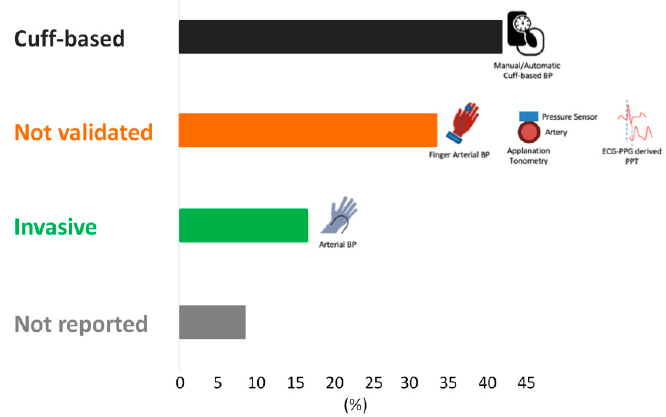
Figure 5. A representation of the gold standards used by each study to obtain the reference blood pressure. BP cuff—sphygmomanometer, either manual or automatic; not validated—Volume-clamp method, applanation tonometry (use of pressure sensors on the artery to detect systolic BP), or another PPG technology that has not been fully validated as the gold standard for BP measurement; invasive IBP—invasive arterial blood pressure.